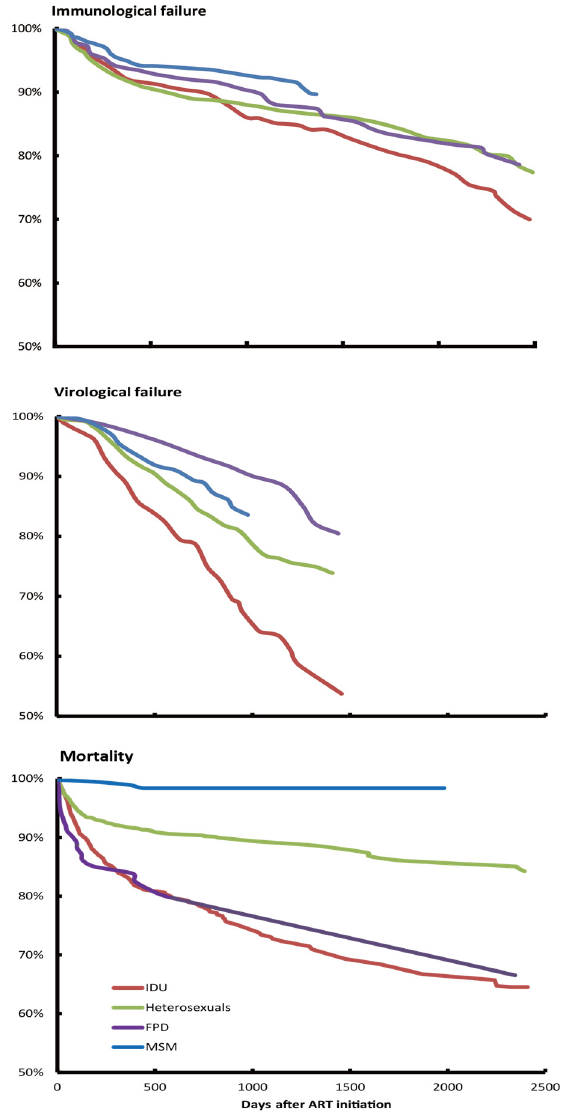
Figure 2. Survival curves for immunological failure, virological failure and HIV-related mortality, stratified by transmission routes.